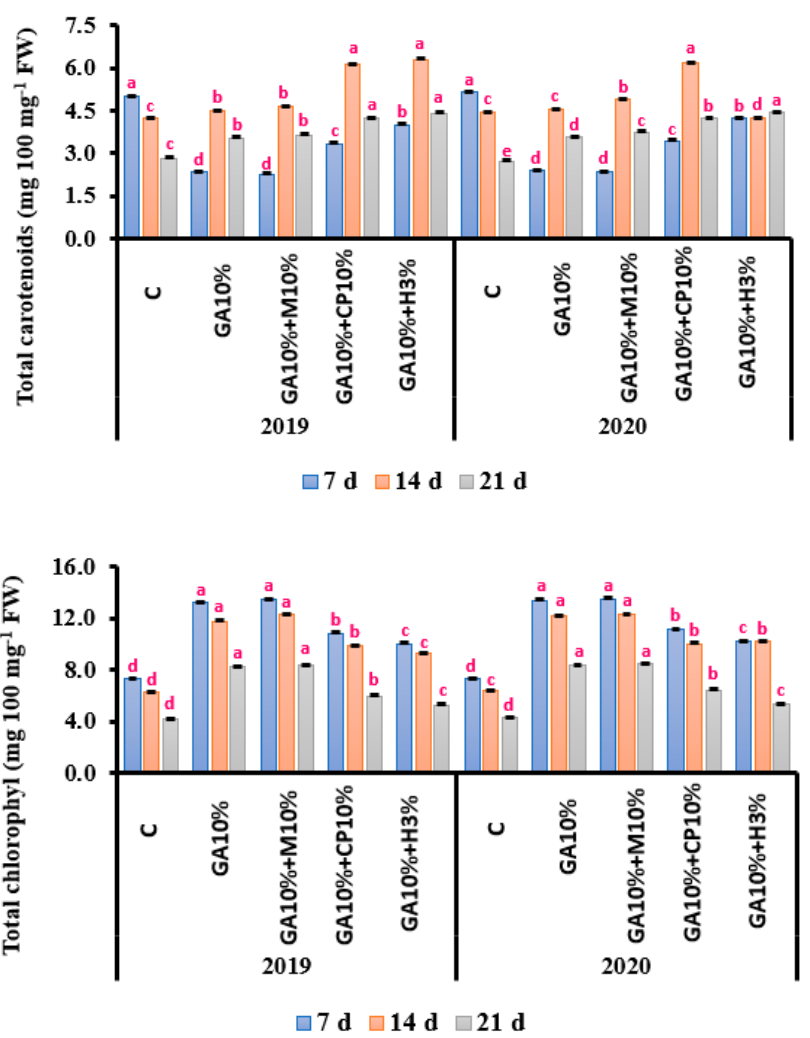
Figure 4. Effect of edible coatings—moringa extract, cactus pear, henna, and GA—on total carotenoid and total chlorophyll (mg 100 mg − 1 FW) of guava during cold storage for 21 days throughout two seasons (2019–2020). The superscript letters, present the significantly between effect of treatments using Duncan’s multiple range tests.